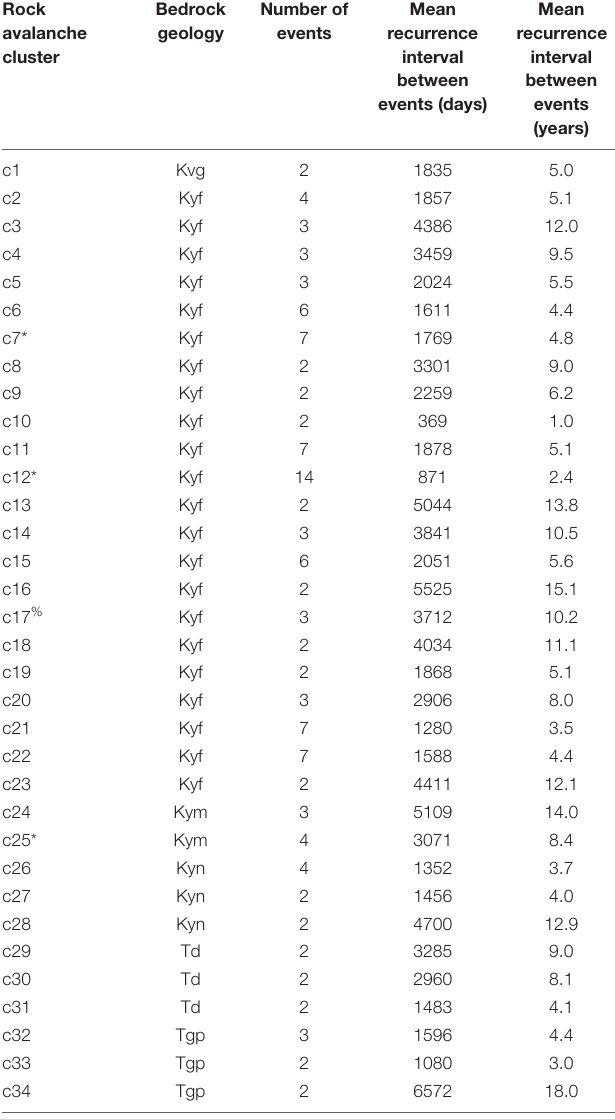
TABLE 2 | Characteristics of 34 rock avalanche clusters (122 rock avalanche events) in the Saint Elias study area. Rock avalanche cluster